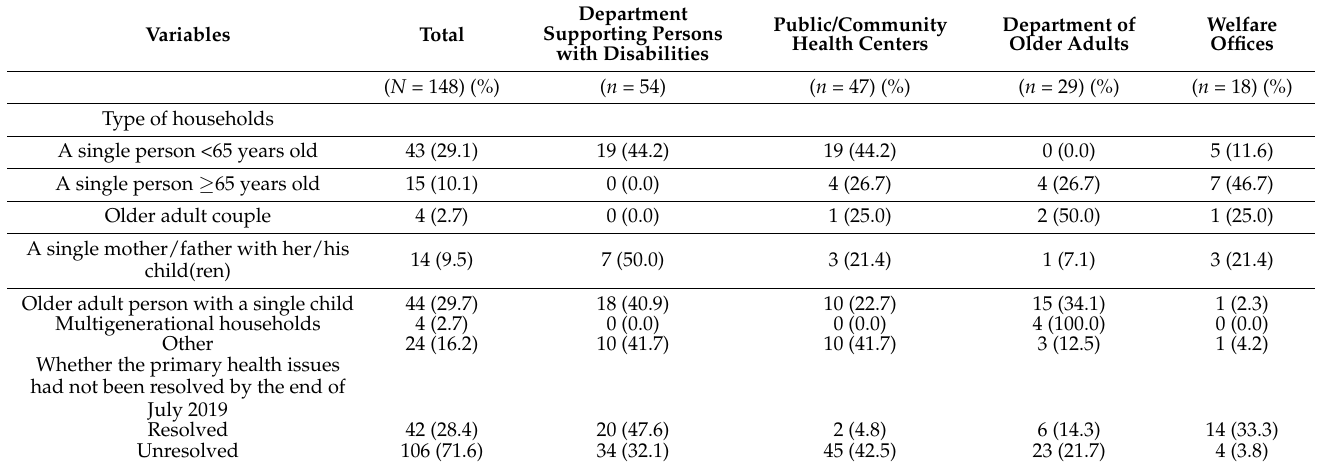
Table 1. Demographic data of the households supported by each